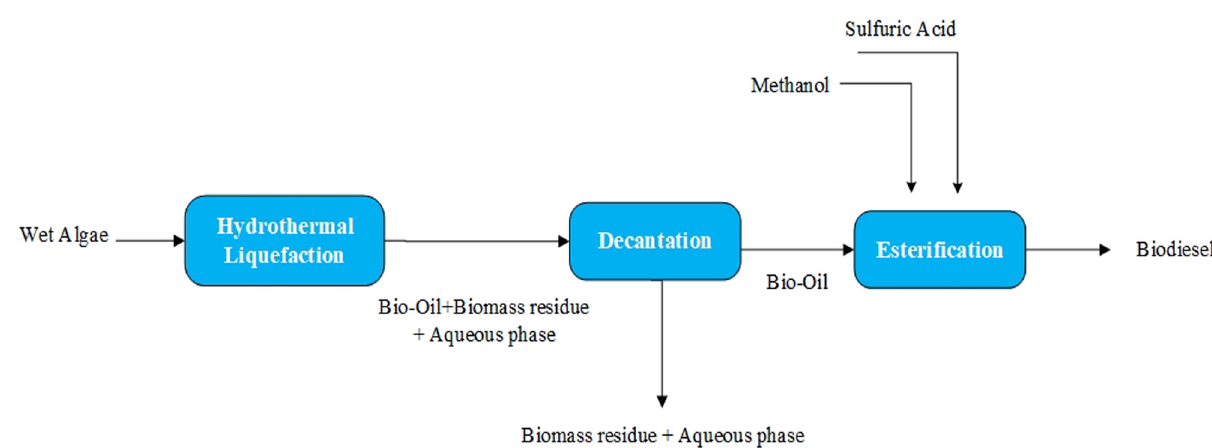
Figure 2: Biodiesel production block diagram via HTL - esteri fi cation